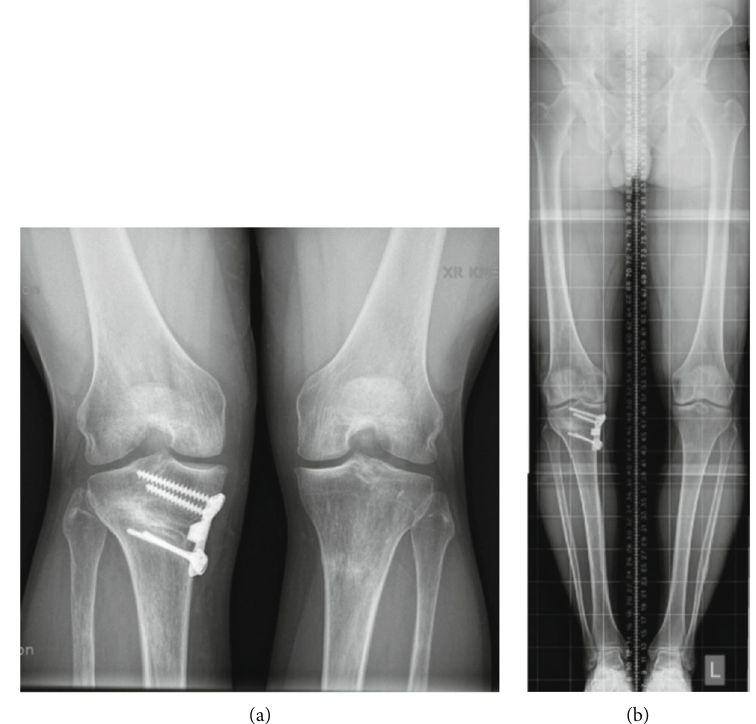
Figure 12: (a) 6-month post-operative PA WB view. (b) 6-month hip-to-ankle WB